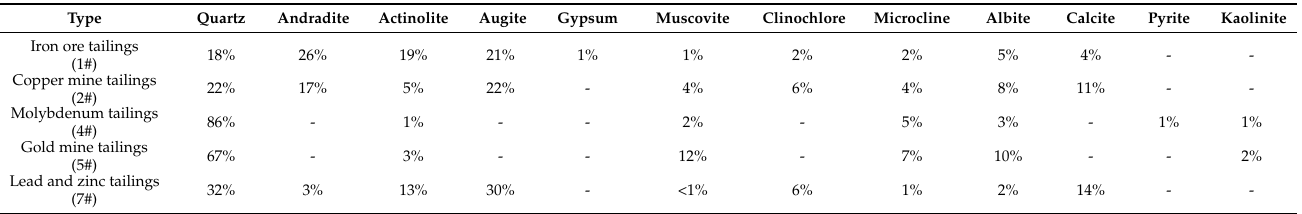
Table 3. Semi-quantitative analysis results of different tailings in typical mining areas of Tibet Autonomous